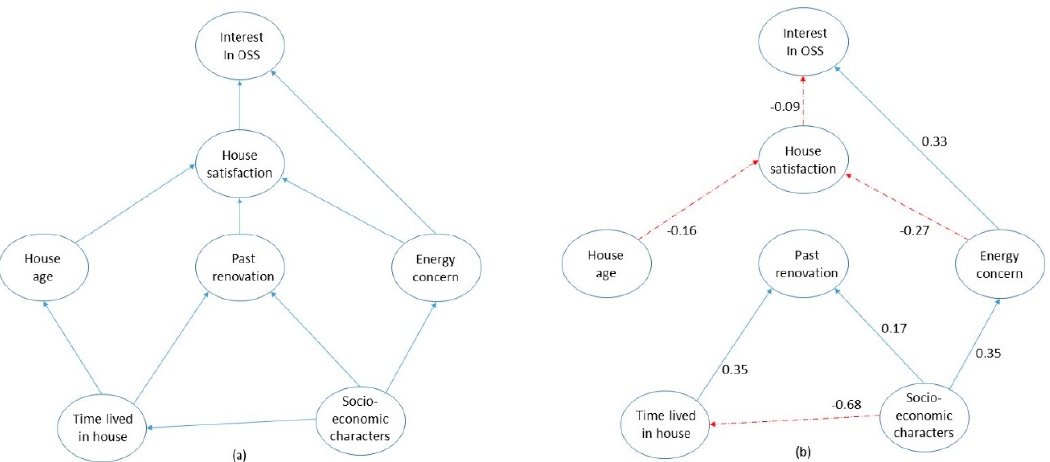
Figure 4. PLSPM analysis of the interest towards the one-stop-shop concept: ( a ) the model structure; and ( b ) the path coefficient estimates (paths with negative coefficients are dashed, and non-significant paths are omitted). Table 4. Direct, indirect and total effects in the one-stop-shop (OSS) model.